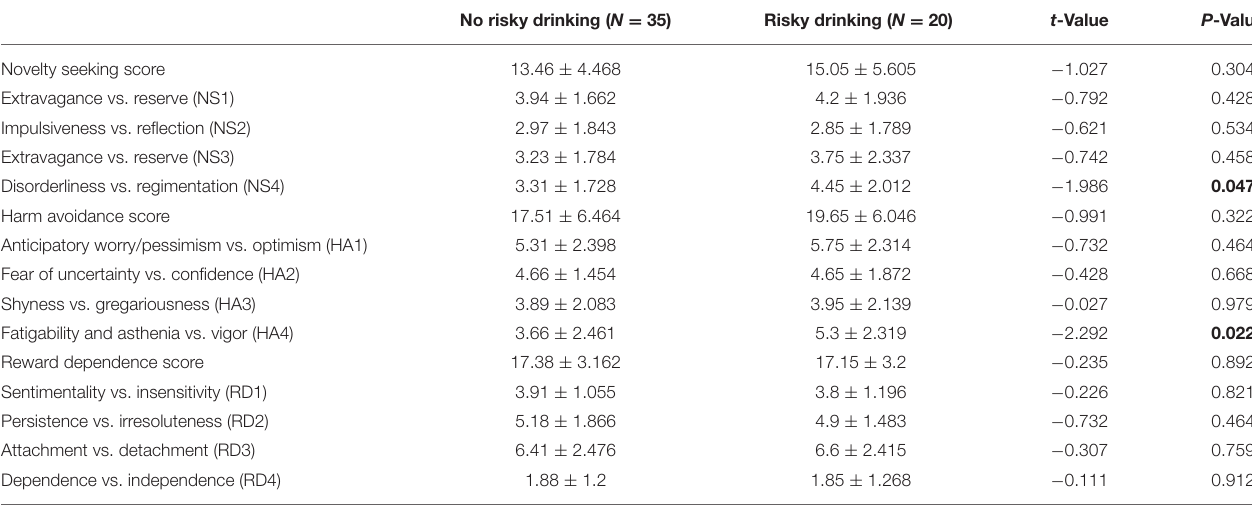
TABLE 2 | Personality of offspring of parents with alcohol dependence based on current risky